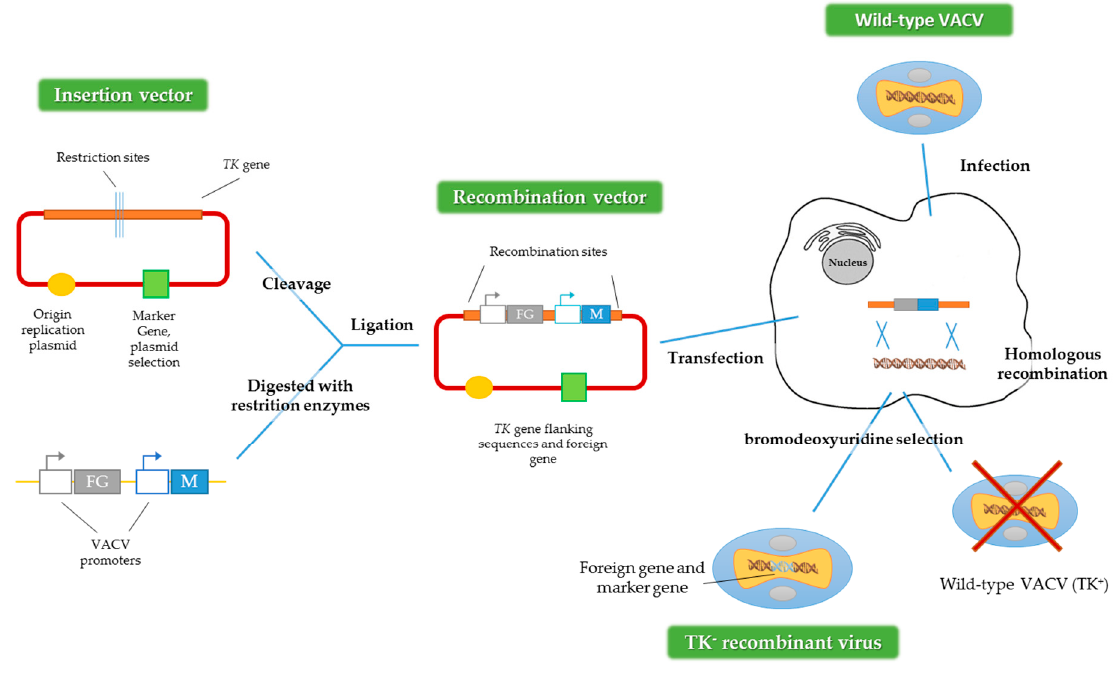
Figure 2. Construction of recombinant VACV vectors by homologous recombination. FG represents the foreign gene and M represents the marker gene and TK : thymidine kinase gene. Adapted from [28].